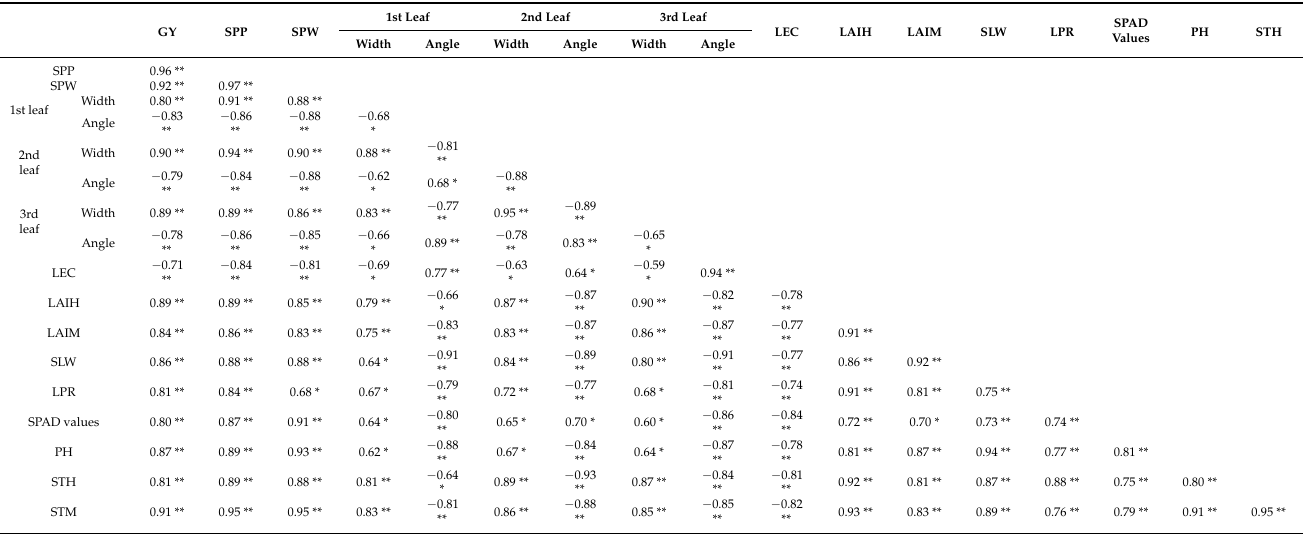
Table 3. Correlation matrix between grain yield and plant morphological traits of rice cultivars.